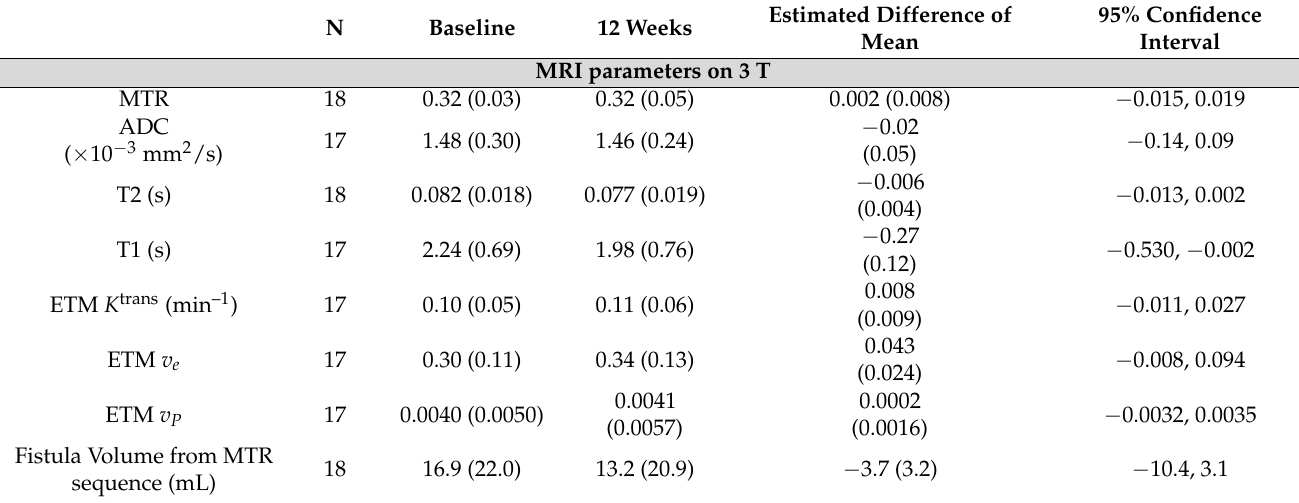
Table 1. Comparisons of fistula MRI parameters (3 and 1.5 T MRI platforms) and clinical indicators before and after treatment. Data are presented as mean (SD). The volumes of the fistula defined on the MTR images before and after 12 weeks of treatment are also presented. The estimated mean differences mean (SEM) and 95% CI between the visits are also